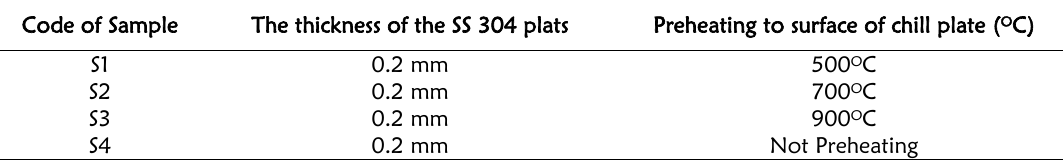
Table 2: Preheating parameters to identify different sample group.